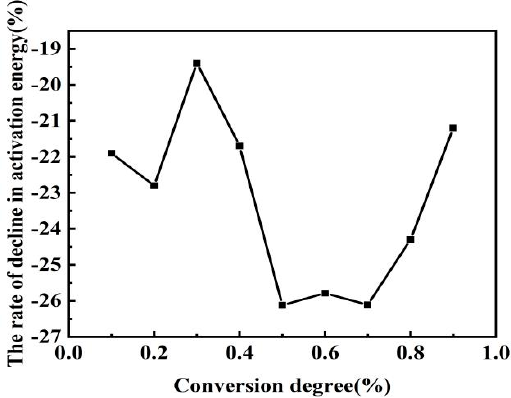
Figure 9. Rate of change in activation energy.